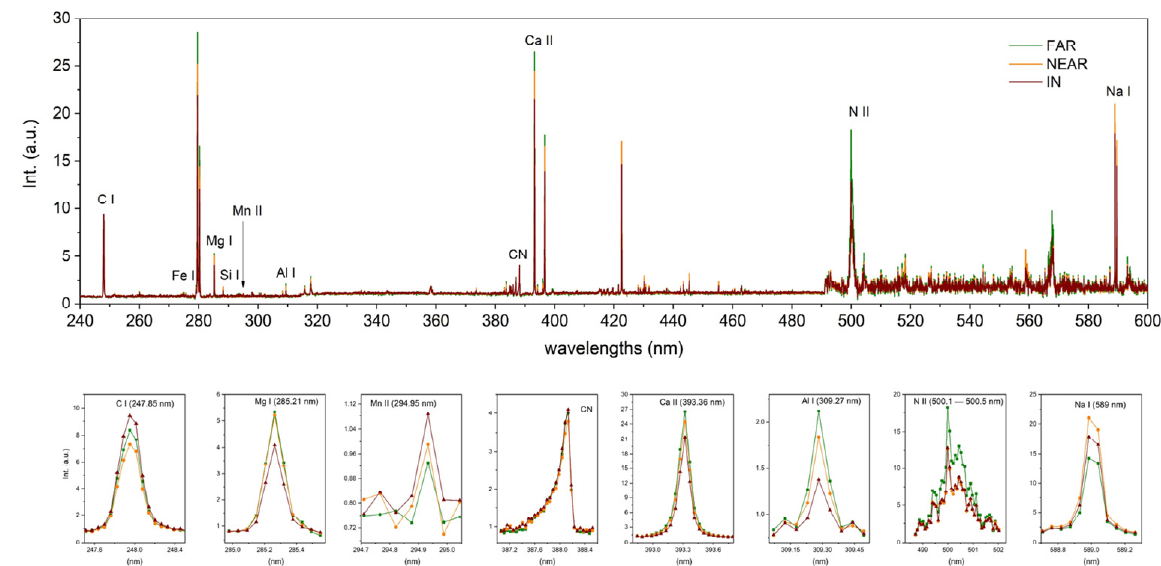
Figure 6. Example of averaged LIBS spectra of chestnut samples collected inside, near and far from the shallow landslide location with identified spectral features. Panels below show some of the selected peaks in larger scale.